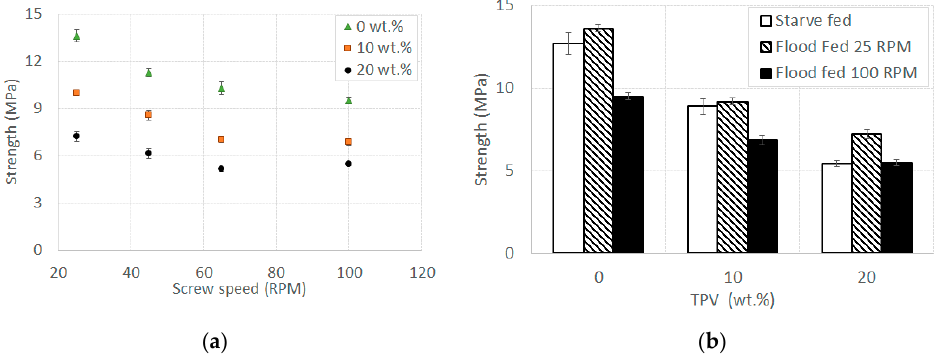
Figure 3. Tensile strength ( a ) vs. screw speed for all materials in a flood fed condition at different screw speeds and ( b ) vs. TPV content in starve fed conditions at 100 RPM, flood fed conditions at 25 RPM, and flood fed conditions at 100 RPM. Error bars indicate the standard deviation.